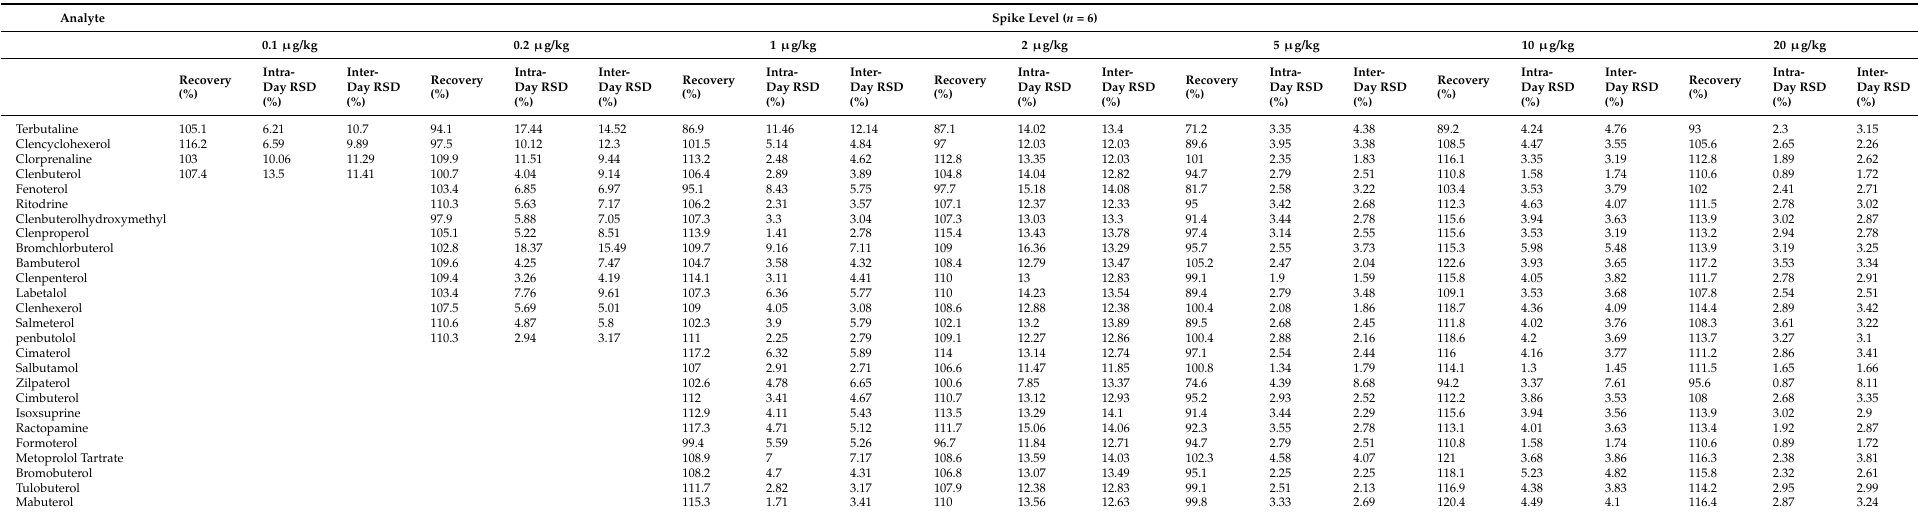
Table 3. Recovery, intra-day, inter-day precisions for